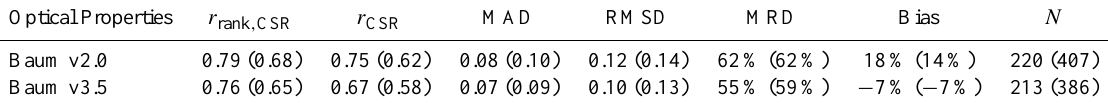
Fig. 9. Circumsolar irradiance for a limiting angle of 2.5 ◦ averaged over all time steps in the test dataset with I tot ,α =2 . 5 ◦ > 200Wm − 2 .